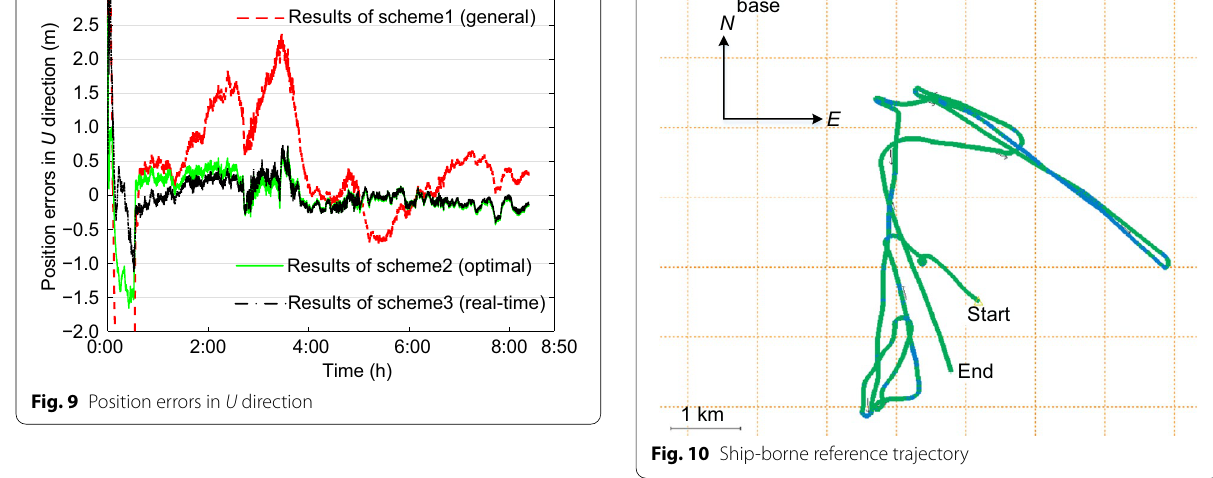
Results of scheme1 (general)